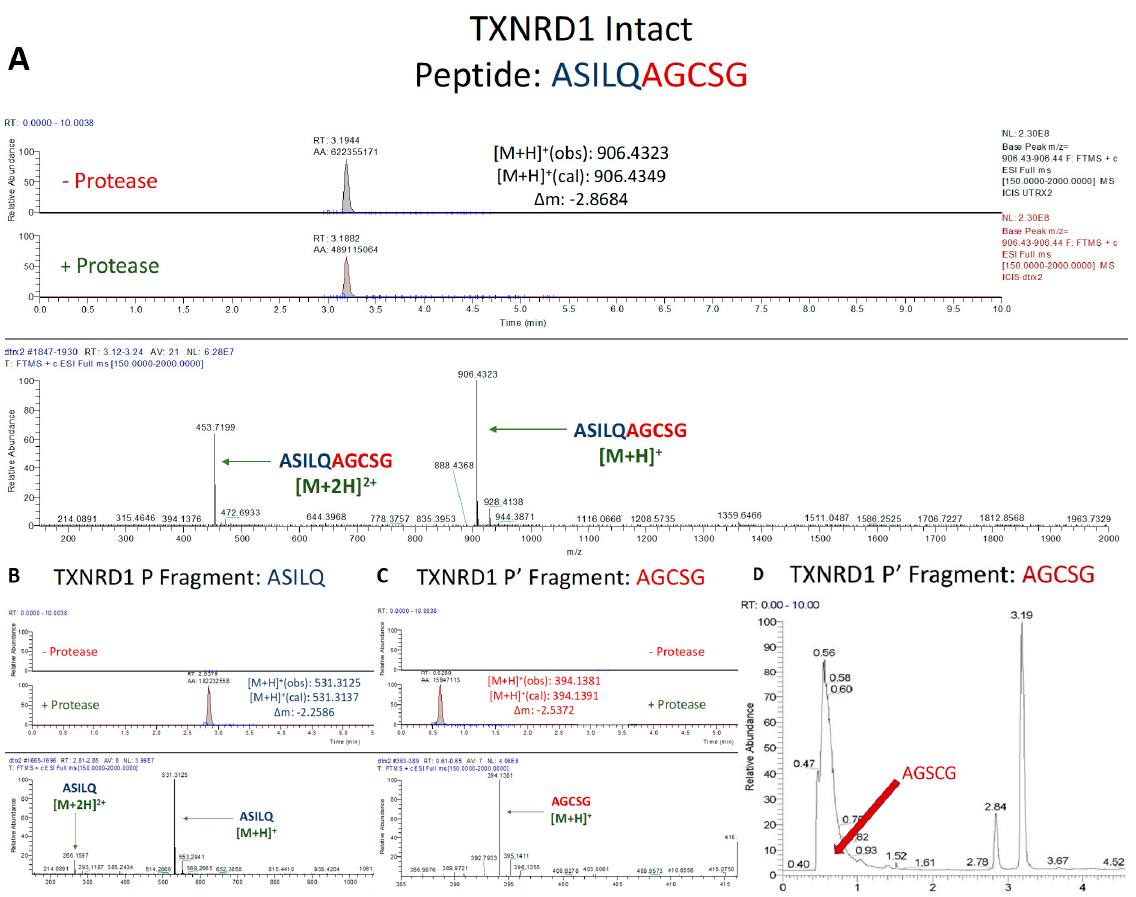
Figure 3. UPLC-MS Data for TXNRD1 Peptide . Depicted are the extracted ion chromatograms for the samples without protease and with protease ( top ) and the mass spectra ( bottom ) for ( A ) the Intact Peptide, ( B ) the P Fragment, and ( C ) the P ′ Fragment. The normalization levels of the base